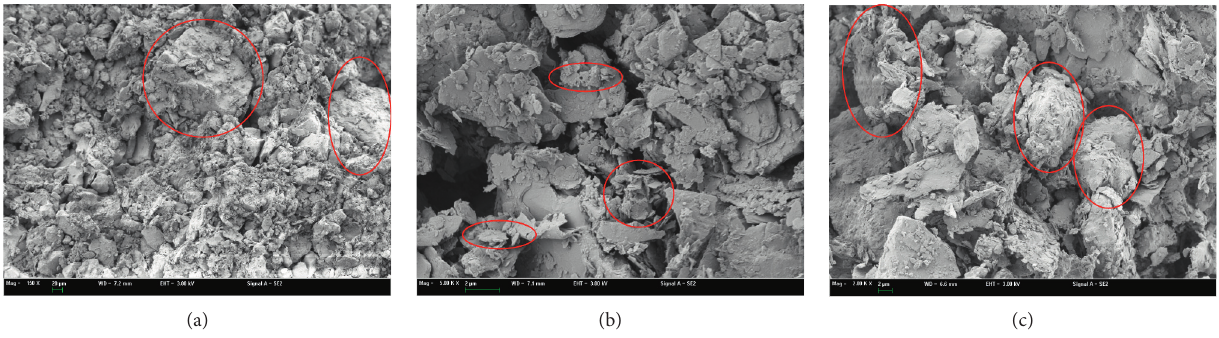
Figure 25: The microstructure of PAM-stabilized soil. (a) 0 cycles. (b) 0 cycles. (c) 10